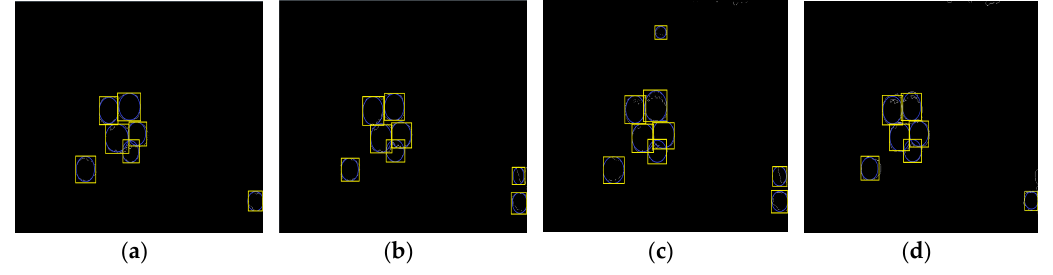
Figure 7. The label extraction of mature litchi fruits. ( a ) The fruit label extraction based on the segmentation result of naive Bayes classifier; ( b ) The fruit label extraction based on the segmentation result of KNN; ( c ) The fruit label extraction based on the segmentation result of Back Propagation (BP) neural network; ( d ) The fruit label extraction based on the segmentation result of support vector machine.